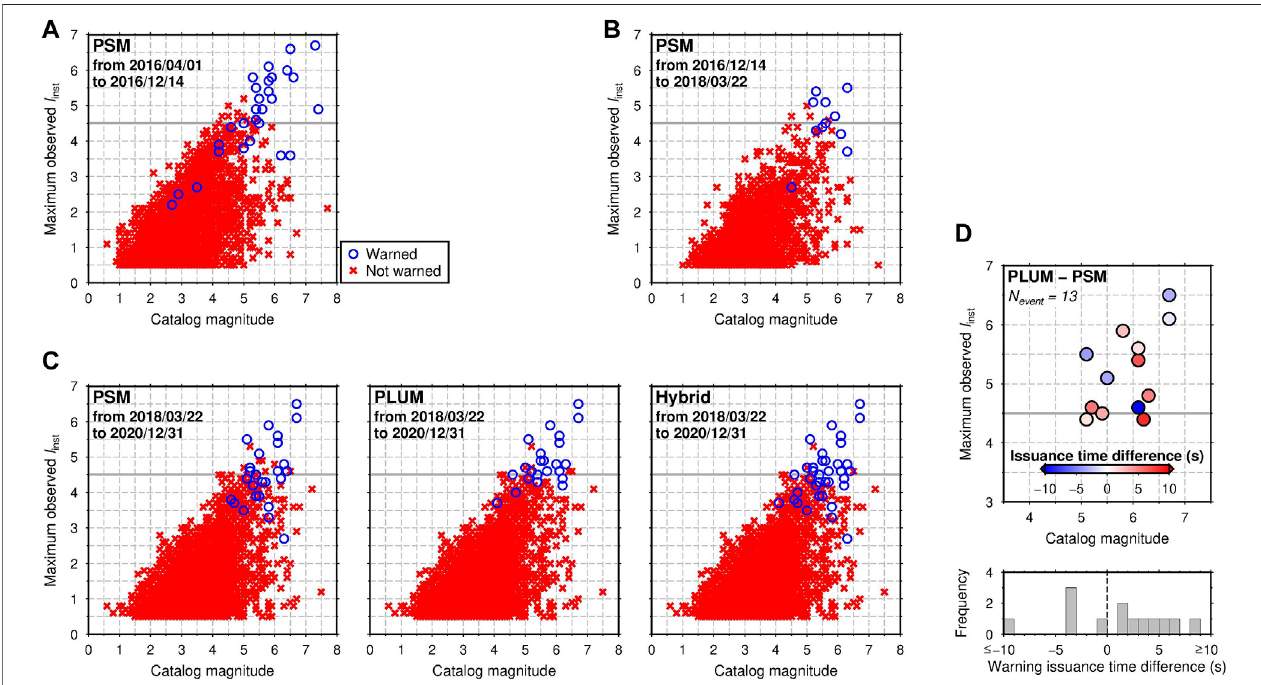
FIGURE5|(A – C) EarthquakeswithawarningissuedbythePSM,PLUM,andhybridalgorithms(bluecircle)andearthquakeswithoutawarningissued(redcross). Inthisanalysis,earthquakeswith I JMA ≥ 1( I inst ≥ 0.5;feltearthquakes)wereused.Theanalysisperiodswerethesameasin Figure3 .Eachearthquakewasplottedwith thepeakobservedintensityandcatalogmagnitude.Formultiplesimultaneousearthquakes,onlyoneoftheearthquakeswasplotted.Thehorizontalgraylinealong I inst (cid:1) 4.5 indicates the warning threshold. (D) Warning issuance time differences between the PSM and PLUM algorithms with earthquakes for which both of the PSM and PLUM algorithms satis fi ed the warning condition during the third period (upper panel) and the histogram of the warning issuance time differences (lower panel). Circles in blue (red) correspond to earthquakes for which PLUM (PSM) satis fi ed the warning condition earlier than PSM (PLUM).